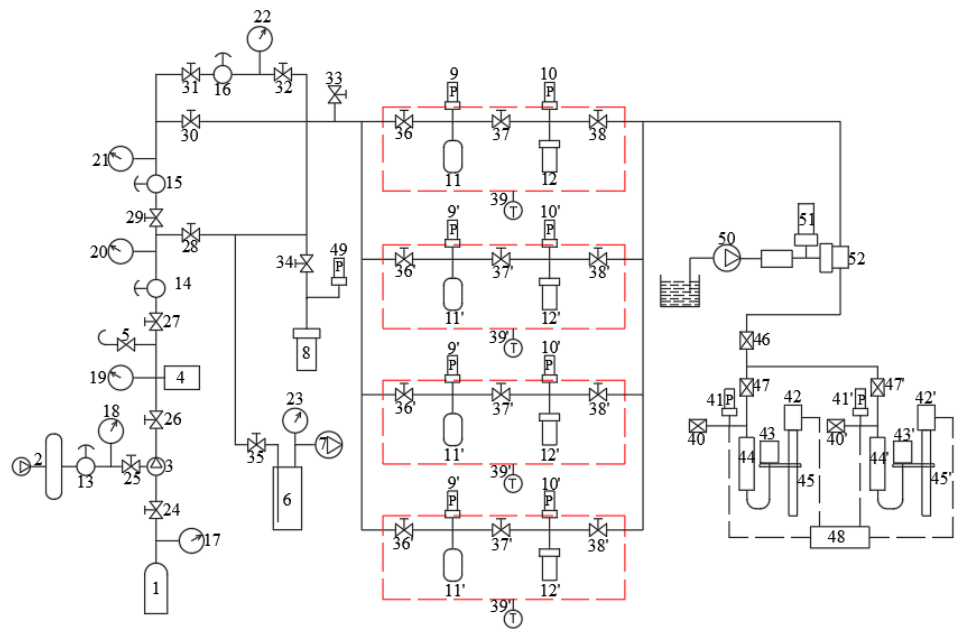
Figure 2. Schematic diagram of experimental device. 1: Gas cylinder. 2: Air compressor. 3: Gas